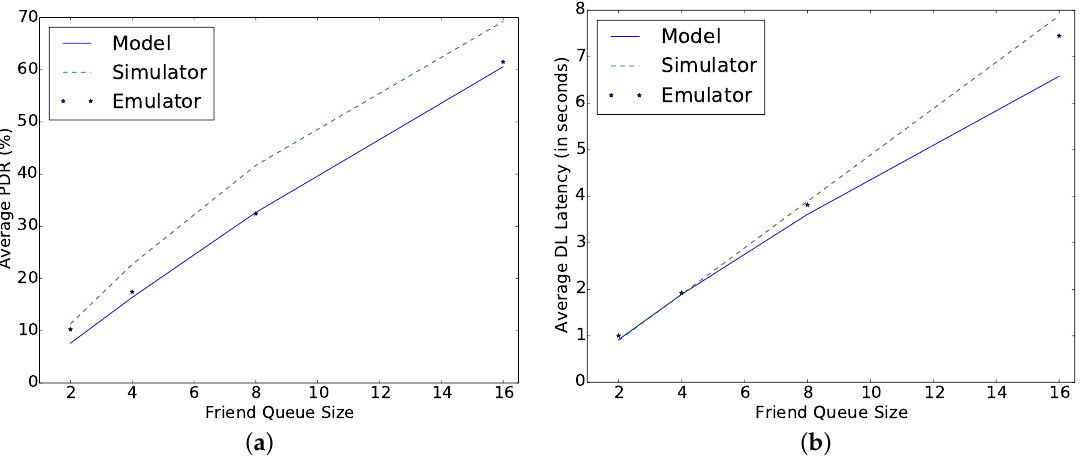
Figure 8. Comparing emulator, simulator, and model for different FQ at µ p = 1 s, T PI = 30 s, C = 1 mF, P h = 0.1 mW, T AT = 5 ms. ( a ) Average packet delivery ratio; ( b ) DL latency.